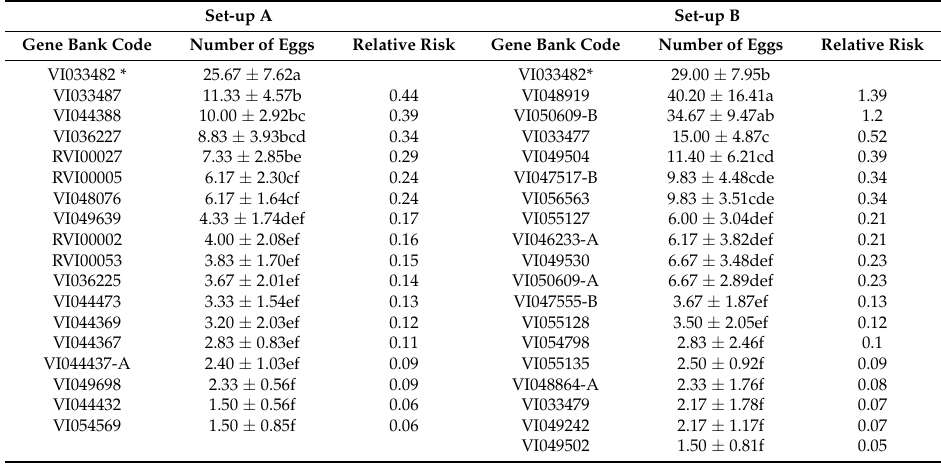
Table 2. Number of eggs (mean ± SE) laid by S. recurvalis on different accessions of amaranth in the choice assays in set-up A and B.